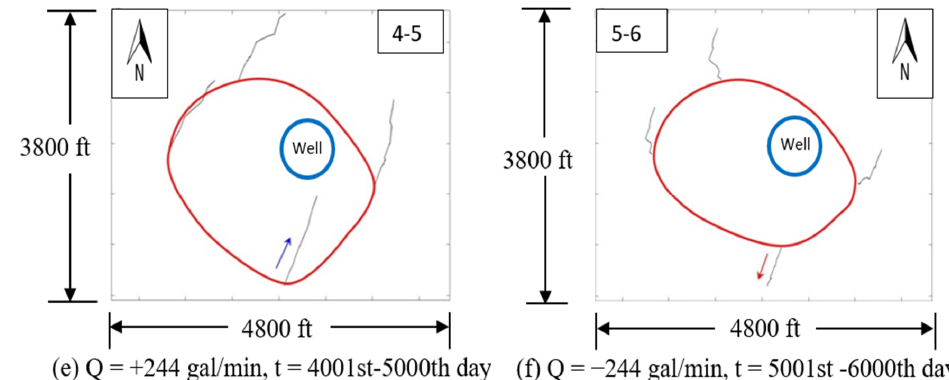
Figure 8. Water circles around a well for 6000 days under pumping and injection conditions at the Meadows Pumping Center, CO, USA. ( a , c , e ) represent the pumping process during the periods of the 1st–1000th day, 2001st–3000th day, and 4001st–5000th day. ( b , d , f ) represent the injection process during the periods of the 1001st–2000th day, 3001st–4000th day, and 5001st–6000th day. For a longer period of time, i.e., 6000 days in this case, water did not flow far away from the well under continuous pumping and injection. For the first 1000 days (Figure 8a), water moved 861.12 ft from the aquifer to the well during pumping. In Figure 8b, water was injected into the aquifer and moved 183.1 ft back to the aquifer from the well. In the following processes (Figure 8c,d), water moved 513.81 ft from the aquifer to the well and 176.41 ft from the well back to the aquifer. Finally, water again moved 659.45 ft from the aquifer to the well and 180.84 ft from the well back to the aquifer